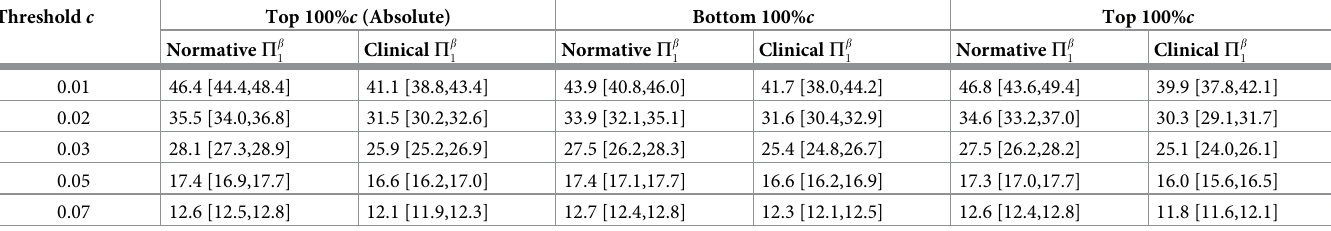
Table 1. Tabular representation of experimental results with ABIDE dataset.